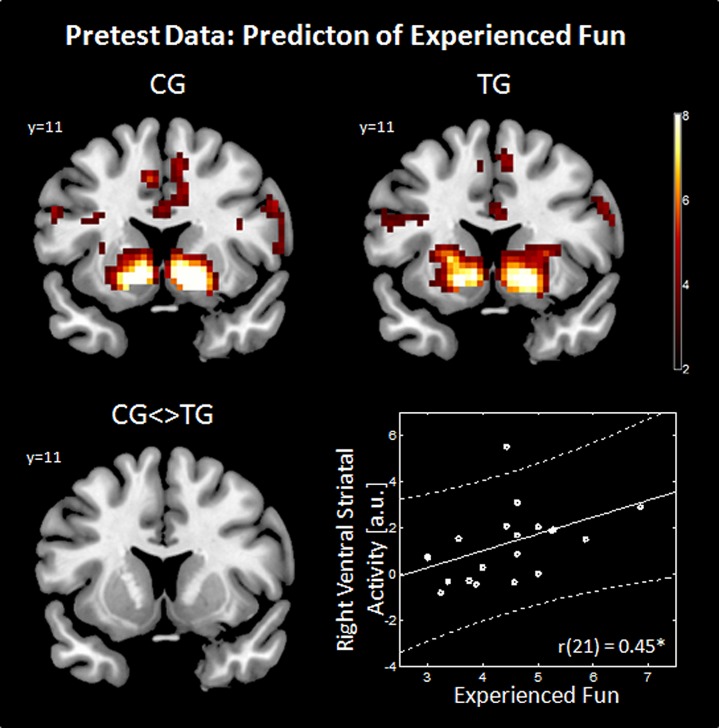
Predictors of experienced fun. The effect of gain anticipation (XX_) against no gain anticipation (XY_) is shown on a coronal slice (Y = 11) in the upper row for the control group (CG) and training group (TG). The group comparison (CG <> TG) is shown in the bottom left panel. Imaging results are threshold with p < 0.05, Monte Carlo corrected. Correlation between right ventral striatal activity (ROI extracted data) and experienced fun (average over weekly questionnaires) is shown in the bottom right panel. a.u., arbitrary units.